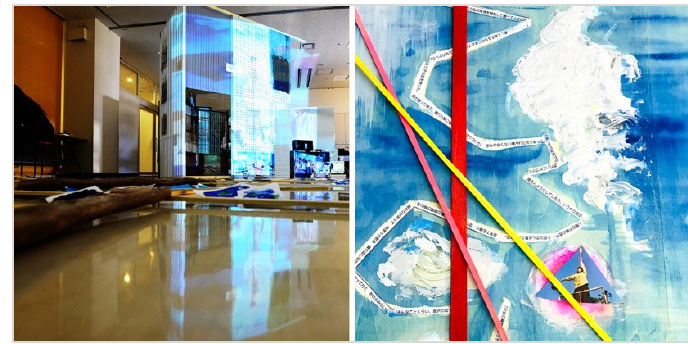
Figure 32 Artworks as a response to the Machi no Kaozukuri project in Toyama.